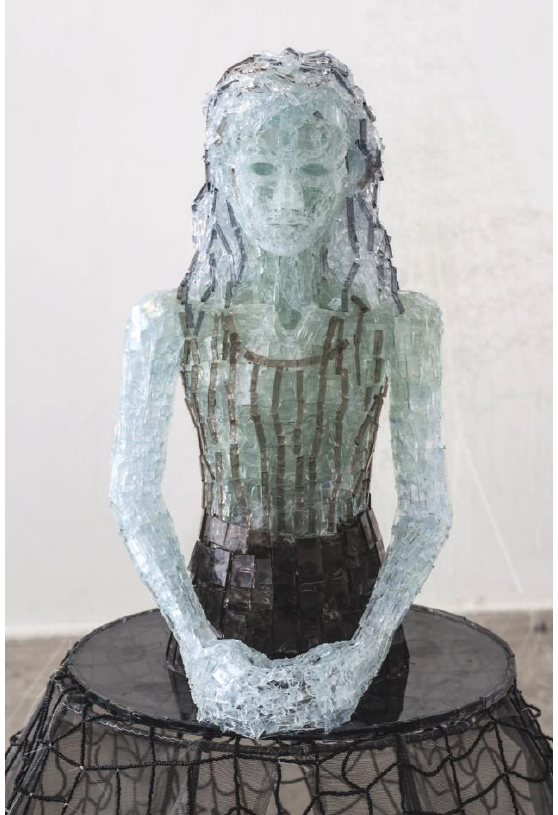
Figure 1. Alina Rom Cohen, Waiting 2014.